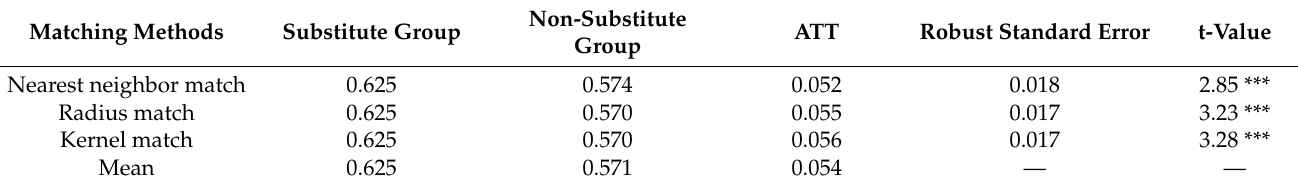
Table 6. Based on PSM estimation of the impact of farmer organic fertilizer adoption on technical efficiency. Matching Methods Substitute Group Nearest neighbor